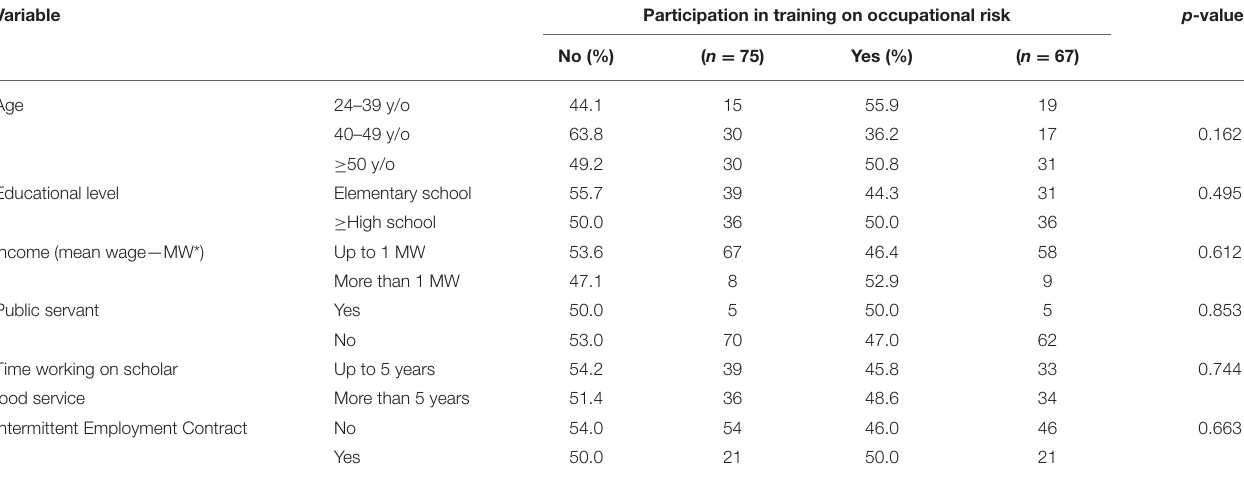
TABLE 4 | Association between participation in training on occupational risk and sociodemographic and work characteristics of food handlers.